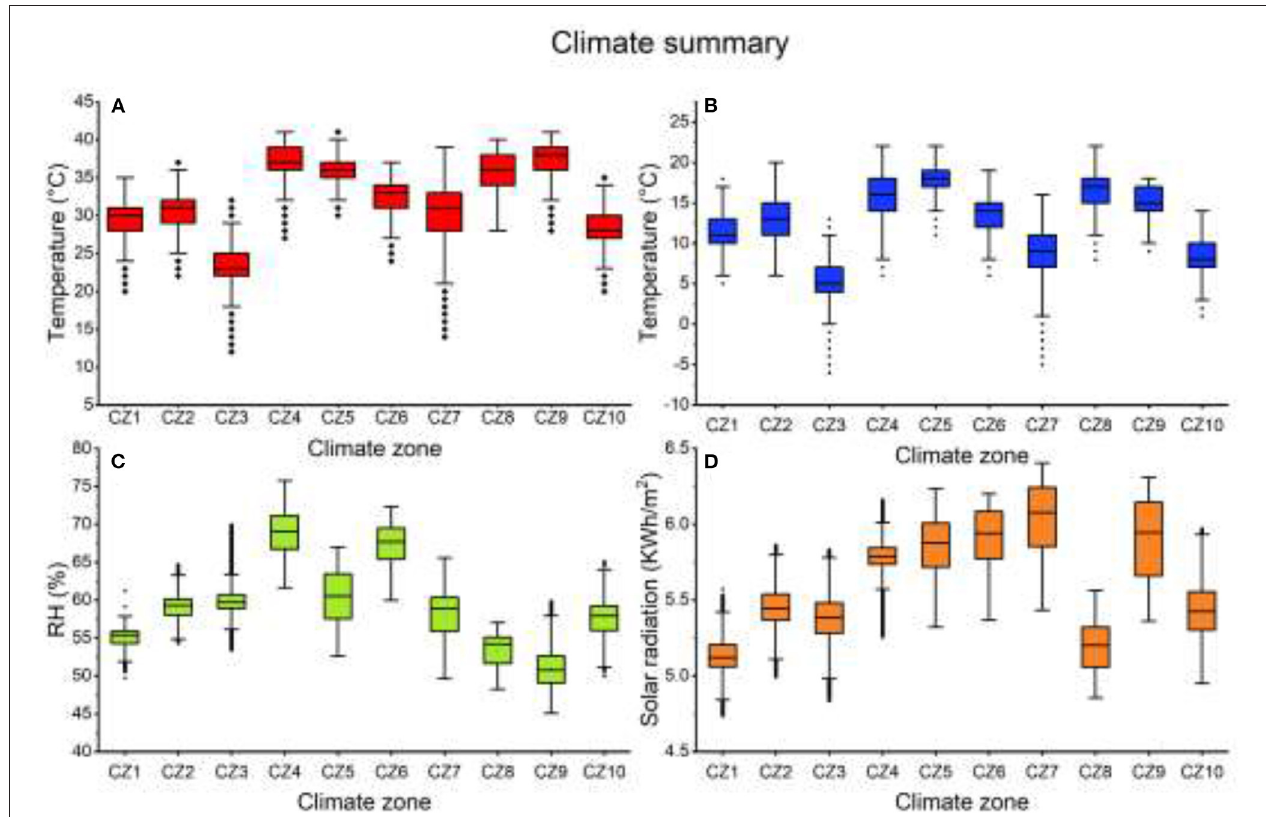
FIGURE 7 | Annual climate summary of new climate zones: (A) maximum temperature; (B) minimum temperature; (C) mean relative humidity; (D) mean solar radiation.